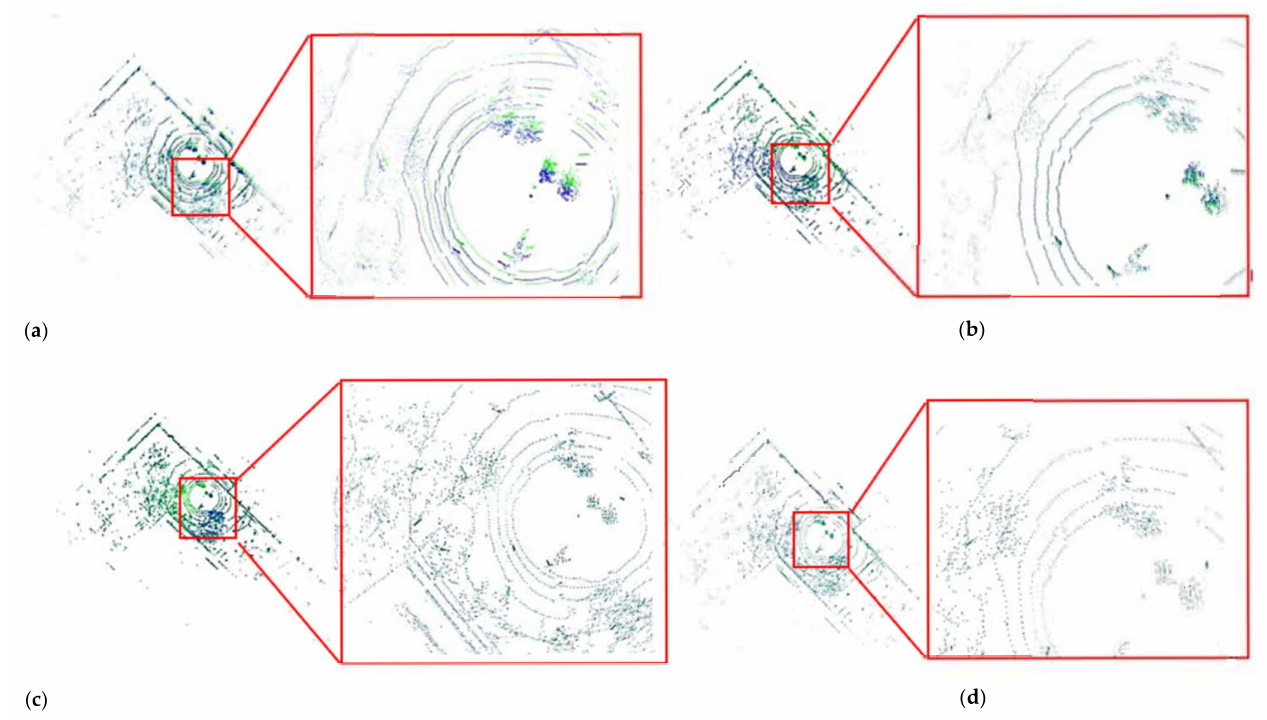
Figure 7. Comparison of registration results of four data association algorithms. ( a – d ) are the results of two point clouds aligned respectively by using the NDT algorithm, the ICP algorithm, the FPFH algorithm, the Super-4PCS